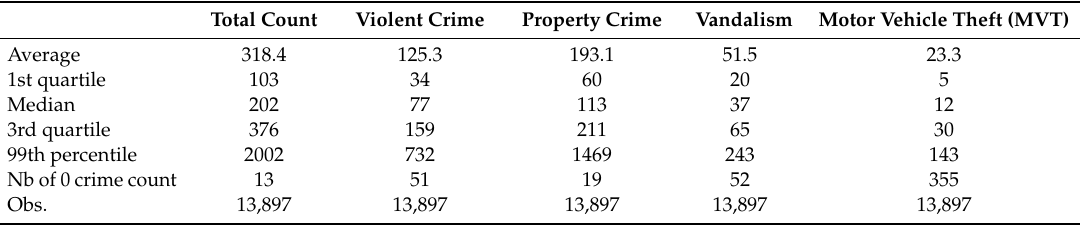
Table 4. Crime target variables, summed over